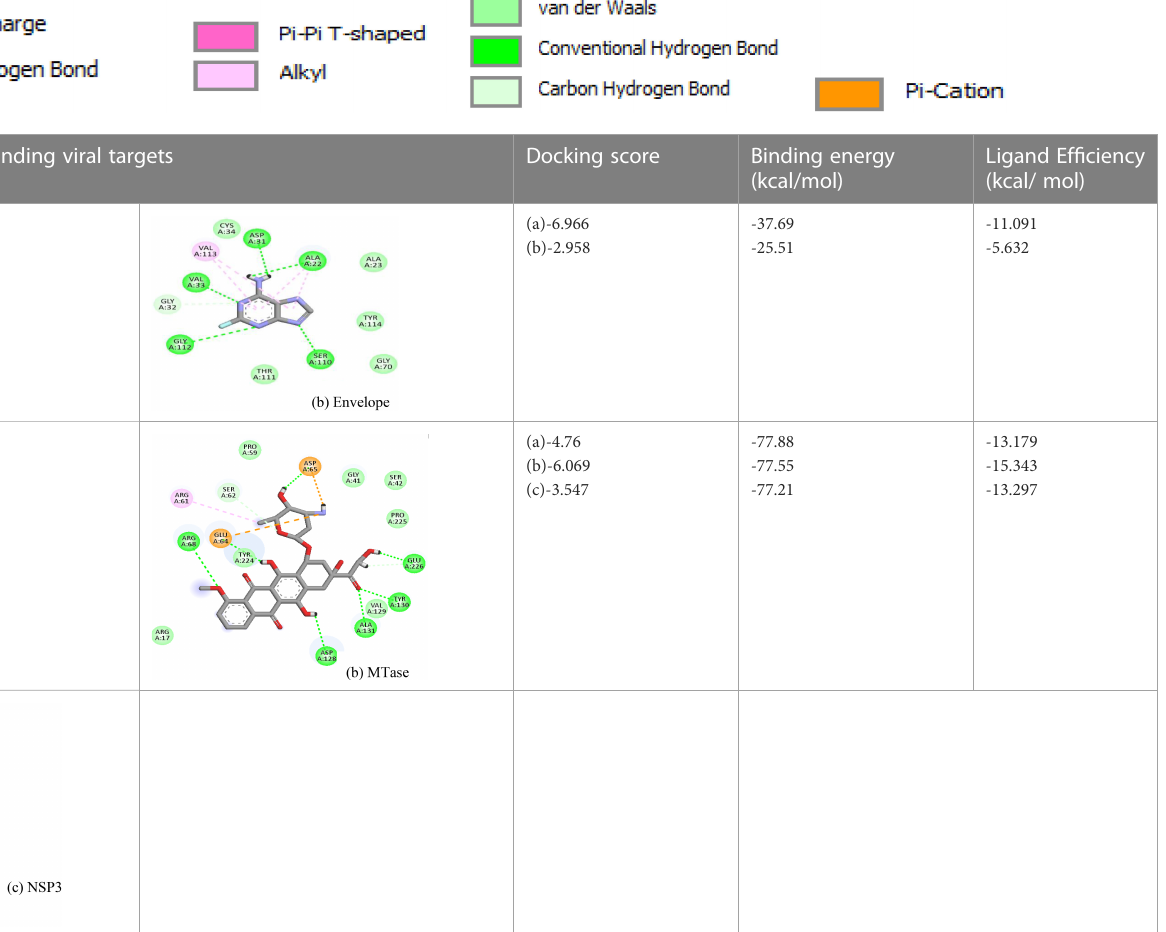
TABLE 4 Molecular docking interactions of the nine FDA approved drugs with CHIKV structural and non-structural proteins based on the binding af fi nity values and best